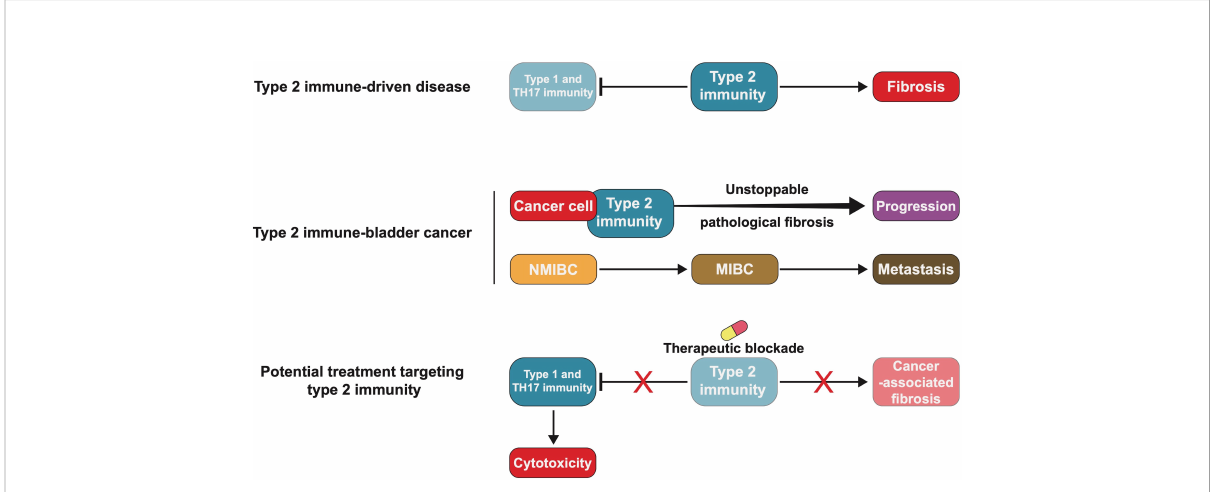
FIGURE 4 Blocking type 2 immunity may be an effective treatment for bladder cancer (BC). Type 2 immune-driven diseases, such as scarring and organ fi brosis, are caused by excessive recruitment of fi broblasts and inhibition of the cytotoxicity of type 1 and T helper 17 (TH17) immunity. BC cells interact with type 2 immunity-related molecules, making pathological fi brosis persistent and causing tumour progression or metastasis. Blocking type 2 immunity could prevent pathological fi brosis and in BC may be worth future exploration and